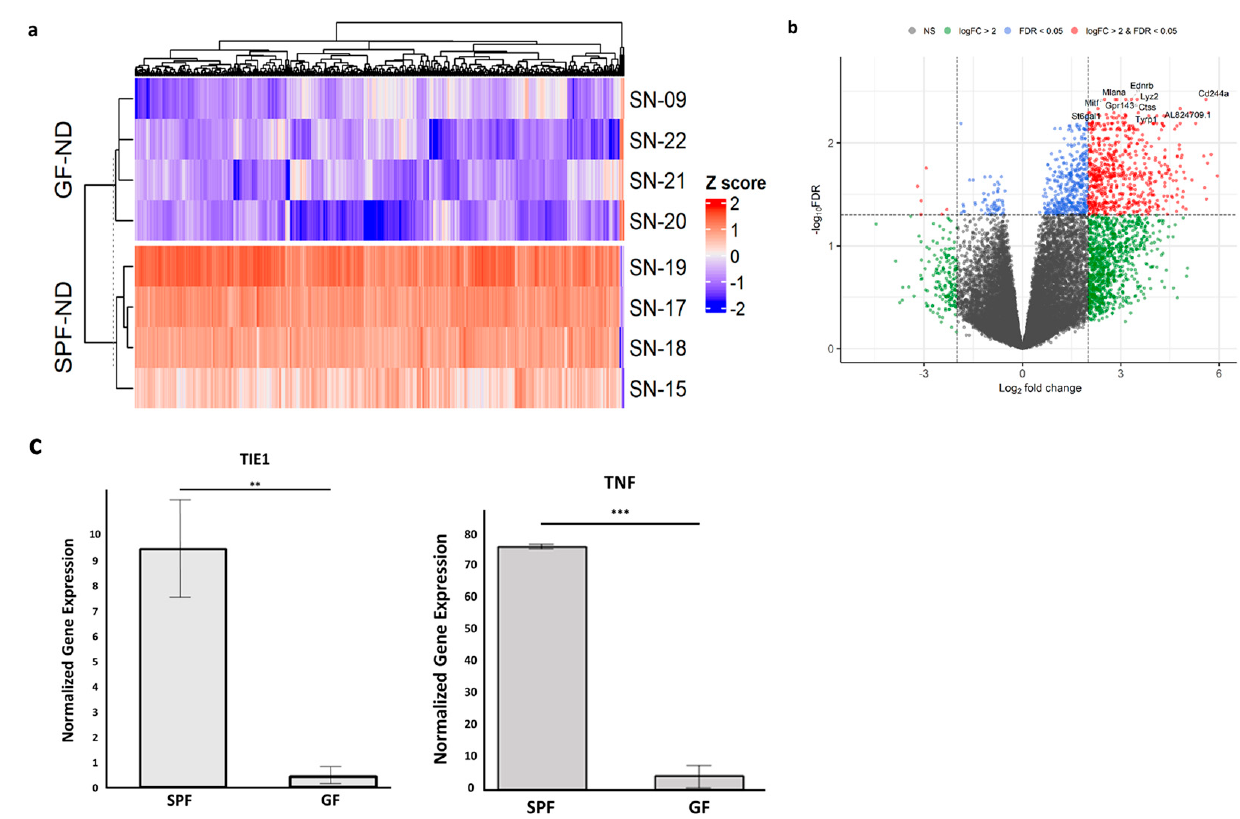
Figure 2. ( a ) Hierarchical clustering of RPE/choroidal genes between GF and SPF mice on normal diet. A total of 660 DEGs were identified with FDR < 0.05 and log 2 FC > 2. Red and blue indicate upregulated and downregulated genes, respectively. ( b ) Volcano plot detailing DEGs in the RPE/choroid of GF and SPF mice. A large majority of significant DEGs were downregulated in GF mice at FDR < 0.05 and log 2 FC > 2. ( c ) RT-qPCR of total RNA extracted from choroids of SPF ( n = 3) and GF ( n = 3) mice, validating identified DEGs ( TIE1 , TNF ). Gene expression levels were normalized with GAPDH. ** p < 0.01, *** p < 0.001.